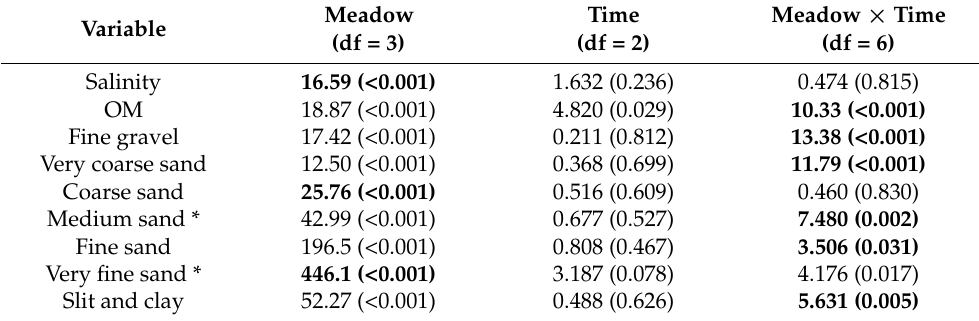
Table 2. Summary of the results obtained in the two-way ANOVA analyses applied for the environ- mental descriptors. Results are expressed by the F -values and associated p -values (in parenthesis). Significant results are in bold. Asterisks above the variables indicate that significance level ( α ) was lowered to 0.01 because data did not fulfil the ANOVA